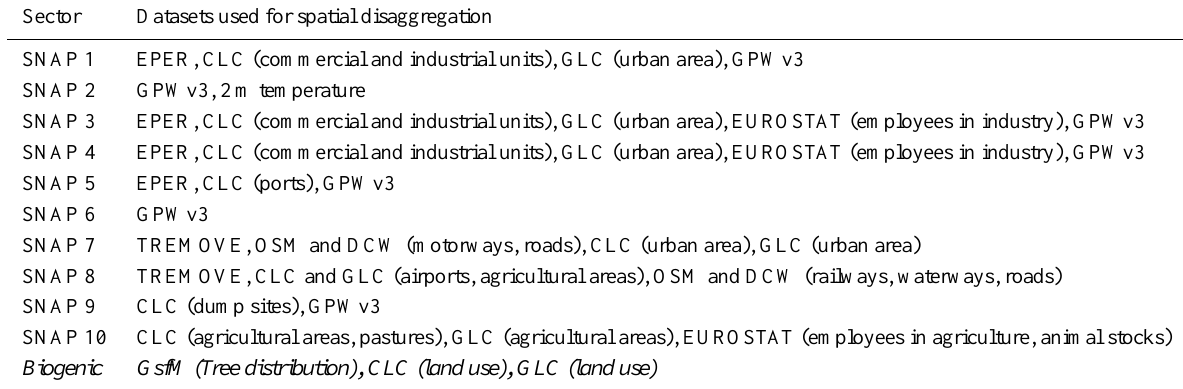
Table 2. Spatial surrogates used for different SNAP sectors and biogenic emissions. A list of abbreviations can be found in Appendix C.